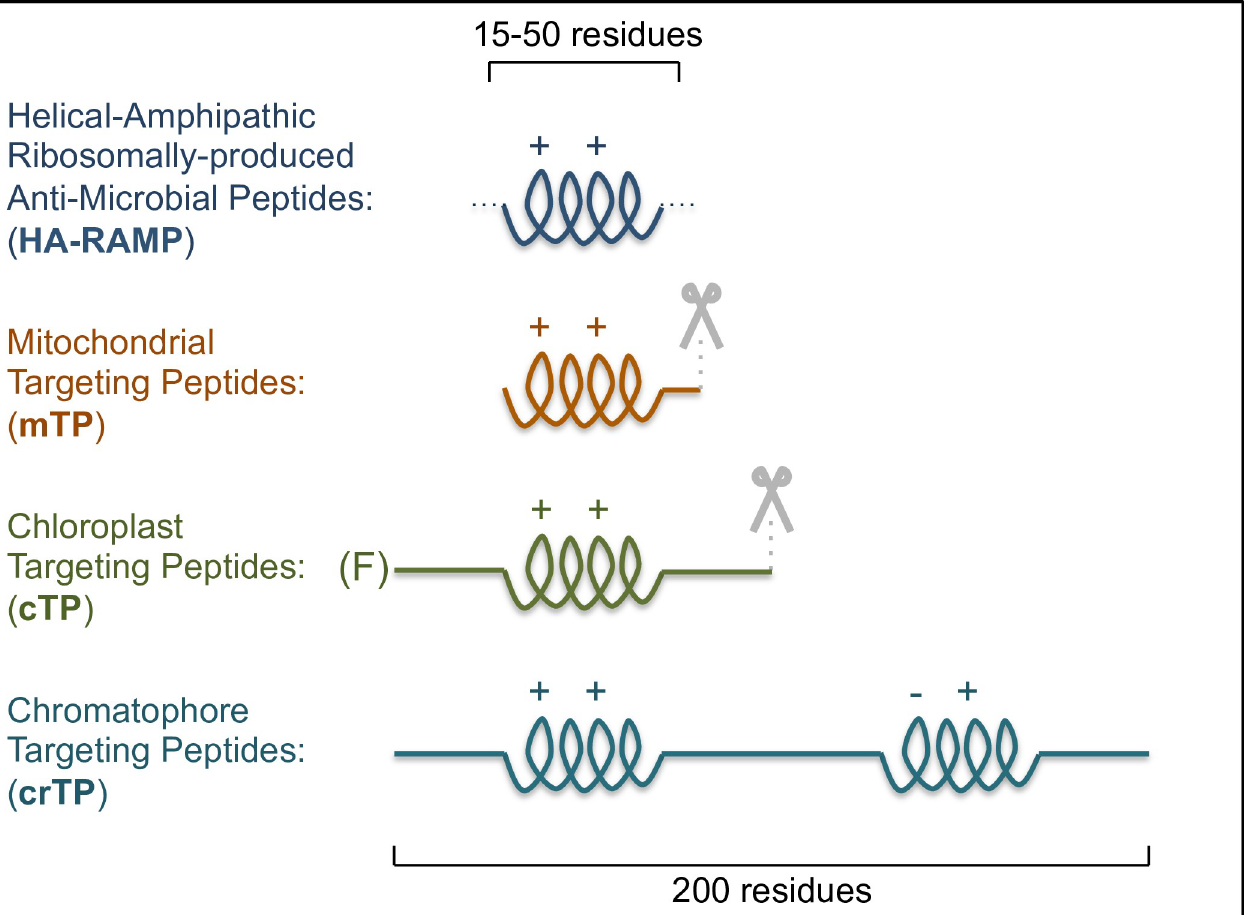
Fig 1. Similarities between TPs and HA-RAMPs suggest organelle import evolved from AMP detoxification. HA-RAMPs and TPs bear cationic (++), amphipathic α -helices. Further domains include cleavage sites (mTP and cTP, indicated by scissors), an uncharged N-terminus (cTP) with a leading Phenylalanine (F) in basal algal lineages, or a long carboxyl terminus (crTP) with a second predicted amphipathic helix carrying both positive and negative charges